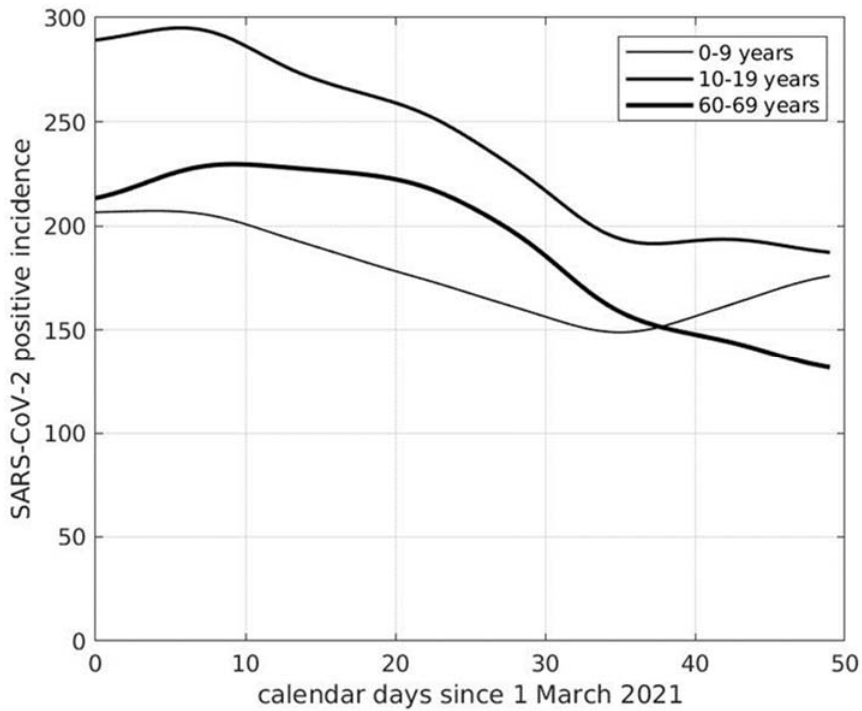
Figure 3. Curves of SARS-CoV-2 incidence in Italy referred to one week and 100,000 inhabitants of different age